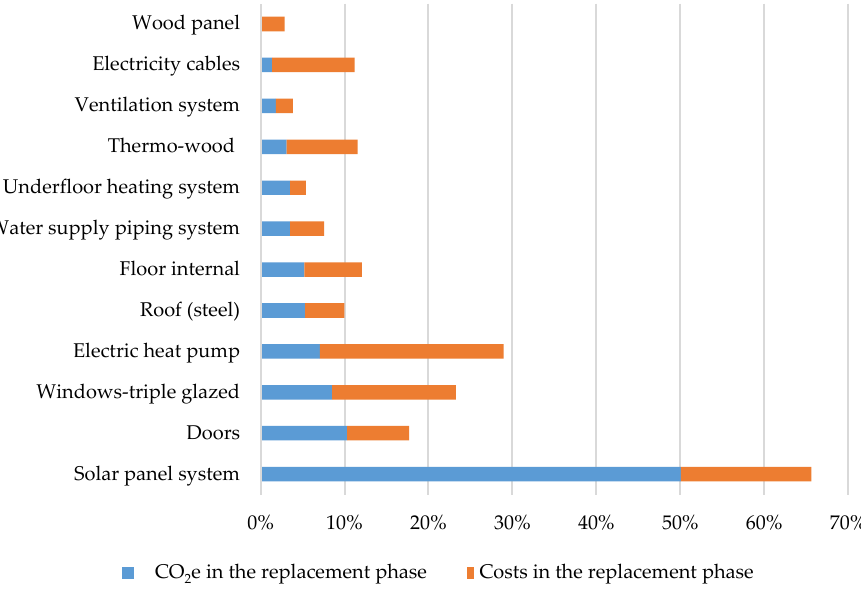
Figure 10. Replacement phase of building materials and installations: emissions vs. costs.